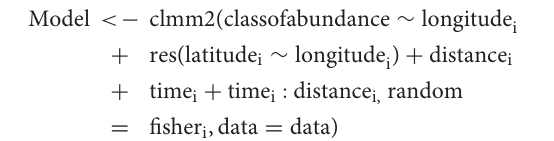
TABLE 2 | Percentages of fishers that clearly remembered (including geographical localization) the selected megabenthic invertebrate species in their by catch and for which we collected clear answers to our